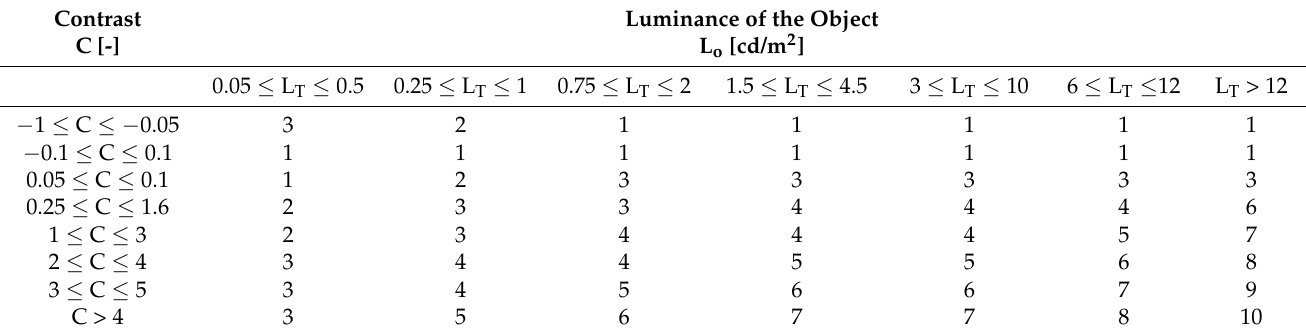
Table 6. System for rating pedestrian’s silhouette lighting quality [33].